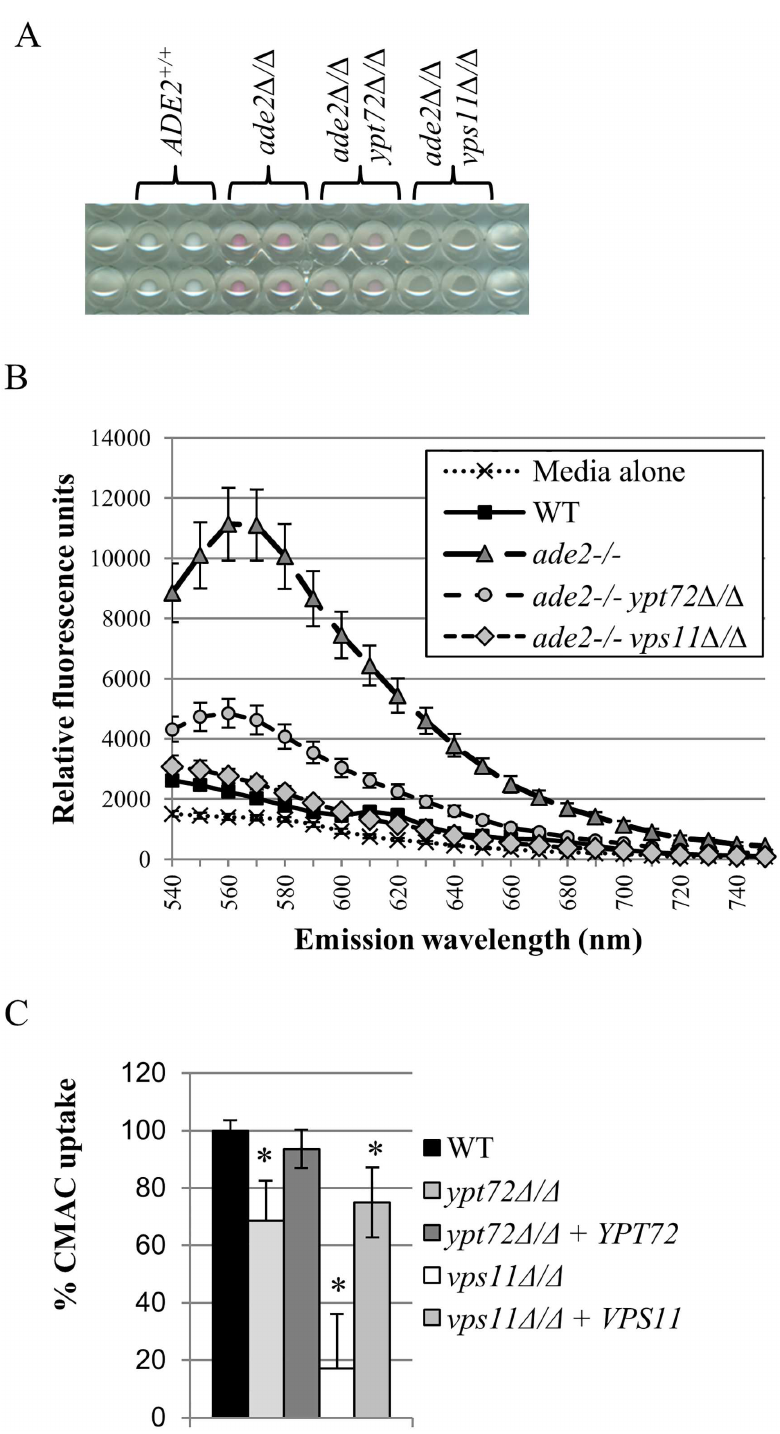
Fig 2. Pigmentation of the ade2 -/- mutant can form the basis of a 96-well plate based screening assay of vacuolar integrity. (A) The indicatedstrains were suspendedat 1 x 10 5 cells/ml of YNB + 5 μ g/ml adenine medium, before 200 μ l aliquots were dispensedinto the wells of a 96-wellplate. The wells were imagedafter 48 hrs incubation at 30˚C. (B) A spectral scan was performed on the wells of the 96-wellplate describedin part (A) above, with excitationat 488 ± 10 nm, and fluorescence emissionread at the indicatedwavelengths. At each wavelength,relative fluorescence is normalized for growth, as measuredby OD 600nm . (C)